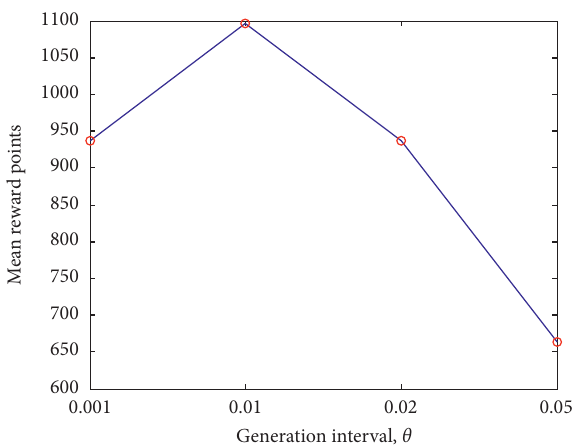
Figure 4: Mean reward points for different generation intervals ( θ ).